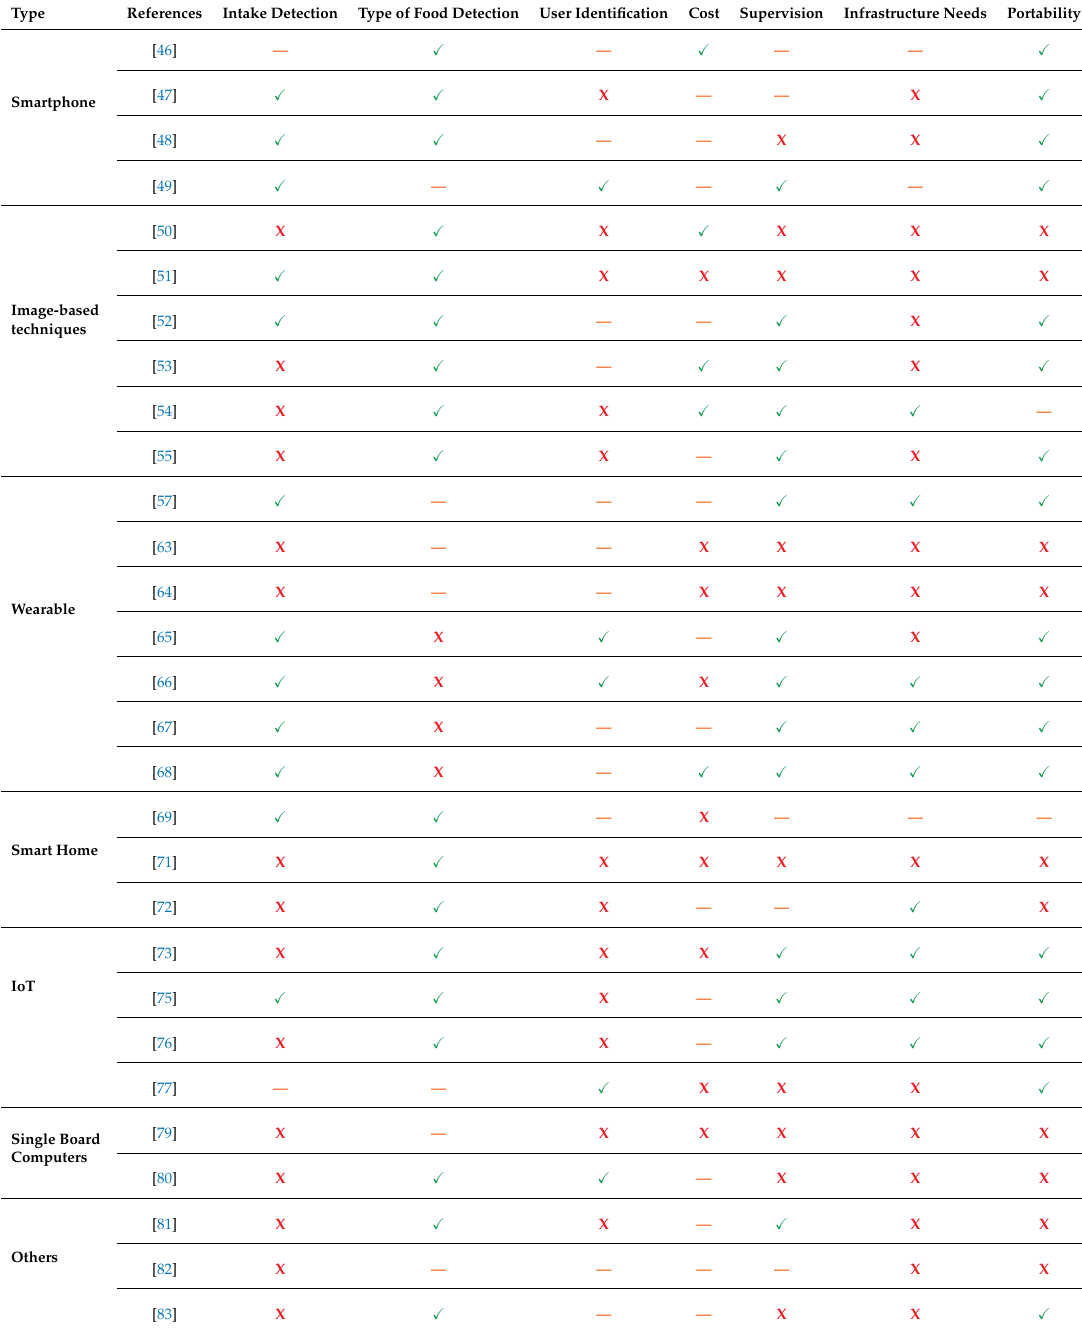
Table 2. Comparative table of the selected papers for